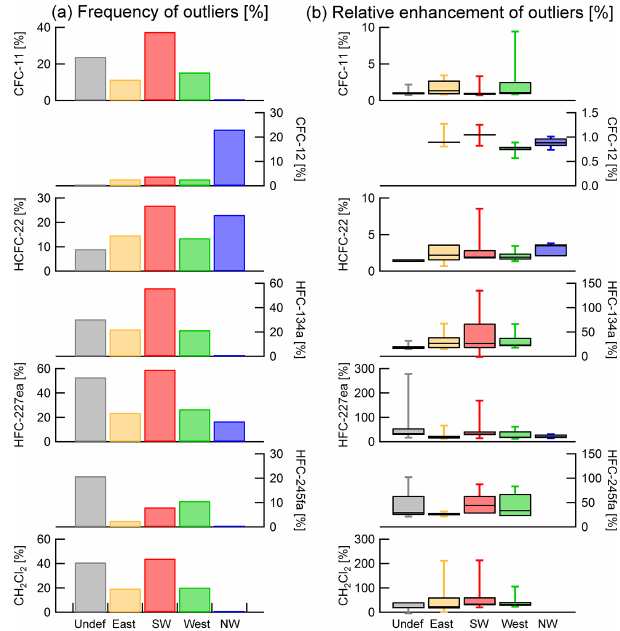
Figure 11. (a) Distribution of samples with enhanced mixing ratios across trajectory origin sectors. Except for CFC-12 outliers occur most frequently when trajectories originate from the south-west. (b) Box–whisker plots of relative enhancement of outlier mixing ratios. Whiskers indicate minimum and maximum enhancements of mixing ratios of samples identified as outliers relative to the base- line fit. Boxes represent the 25th and 75th percentiles, and bars in- dicate the median for each sector. Remarkable features are the high relative enhancements of CFC-12 and HCFC-22 when trajectories originate from the north-western sector and high outlier enhance- ments of dichloromethane under easterly